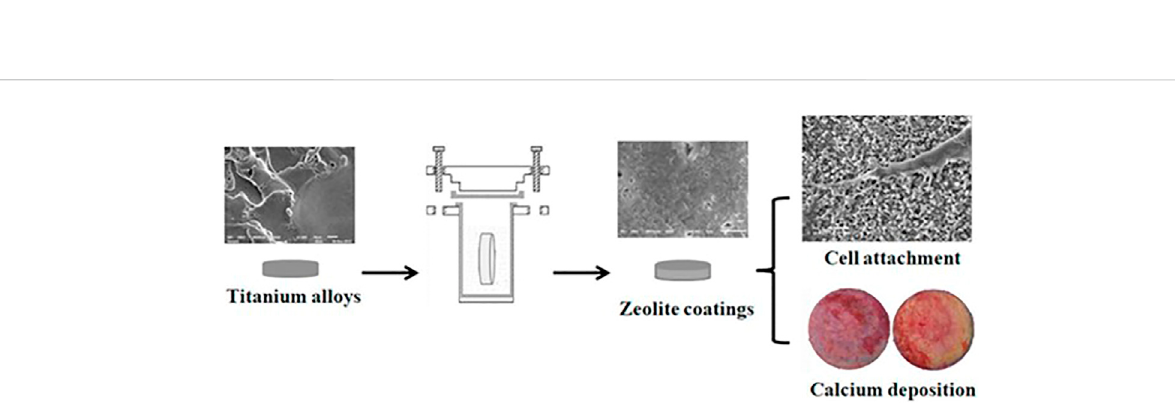
FIGURE 5 Zeolite coatings on titanium alloys which could improve the cell attachment and facilitate the bio-mineralization (Li et al.,